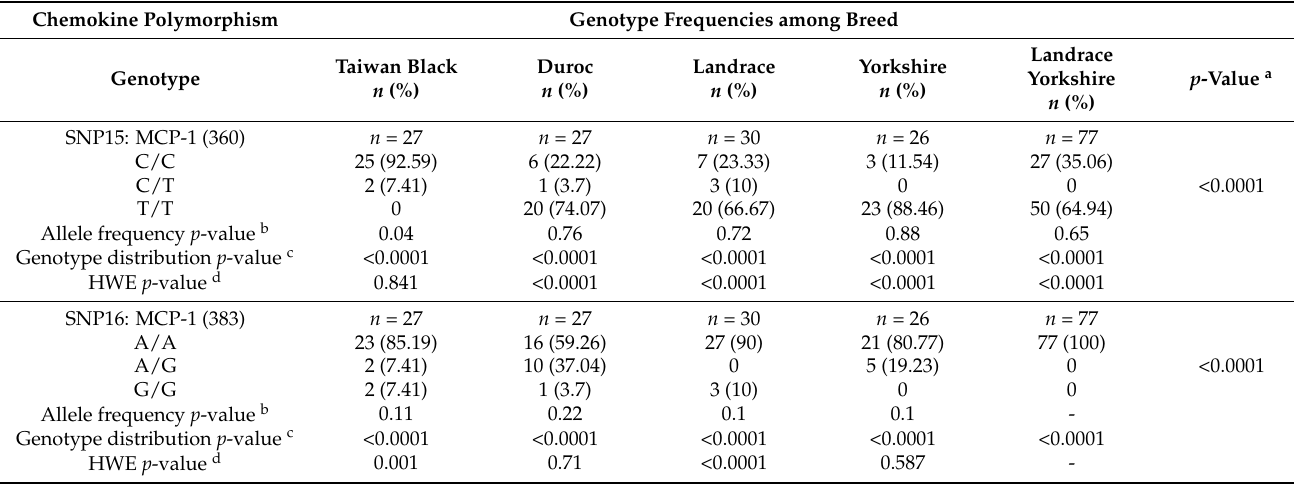
Table 4. The genotype distribution of SNPs in chemokine genes and their association with different pig